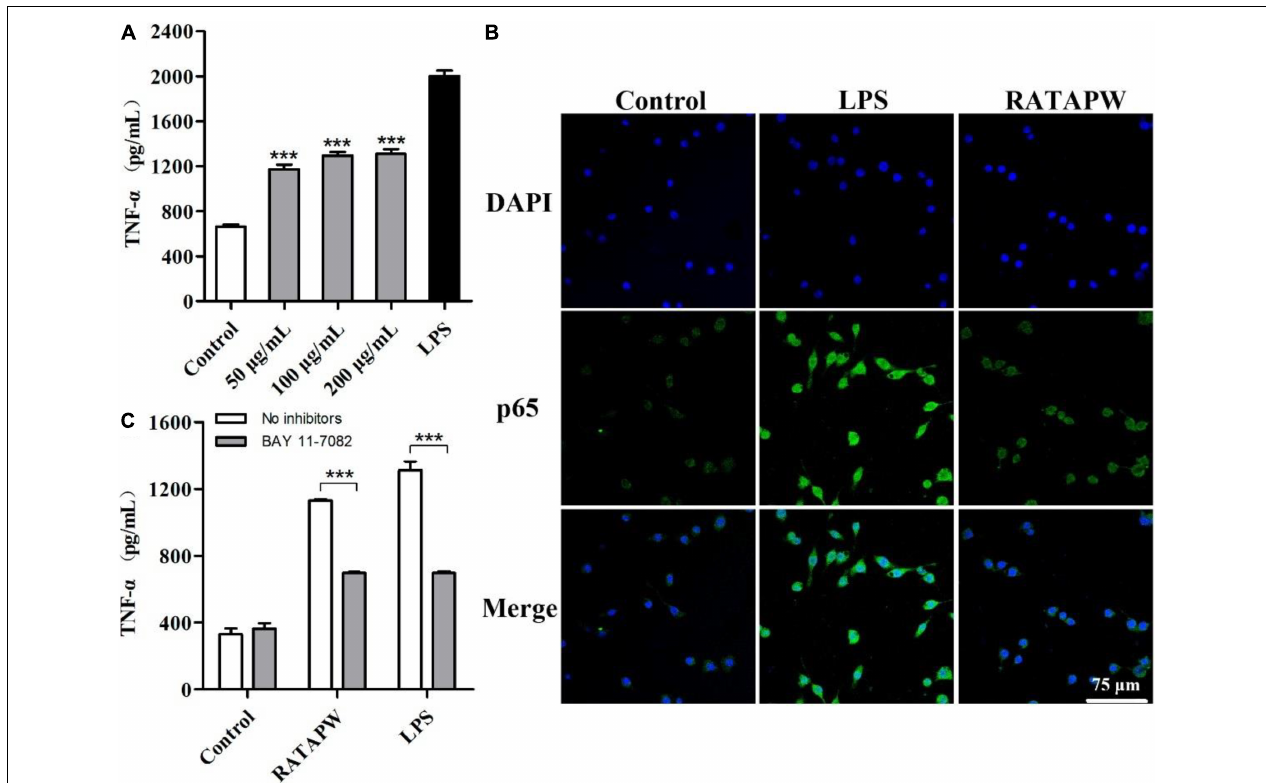
FIGURE 6 | RATAPW activates macrophages via the NF- κ B pathway. (A) RAW264.7 cells were incubated with RATAPW for 24 h, and TNF- α production was tested. *** p < 0.001 were compared with the control group. (B) An amount of 200 µ g/ml RATAPW or 2 µ g/ml lipopolysaccharide (LPS) were added to RAW264.7 cells for 3 h, and p65 protein (green) in the nuclei (DAPI) was determined by laser confocal microscopy. (C) After being pretreated with PBS (no inhibitors) or BAY 11-7082 for 1 h, RAW264.7 cells were incubated with 200 µ g/ml RATAPW or 2 µ g/ml LPS for another 24 h. TNF- α production in the supernate was tested.